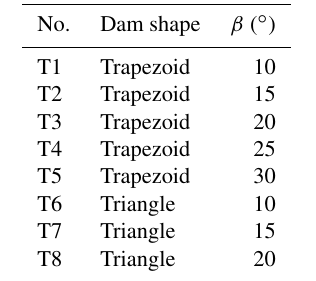
Table 2. Landslide dam parameters. The value of H d /W d ranges from 0.1 to 0.3, and V 1 / 3